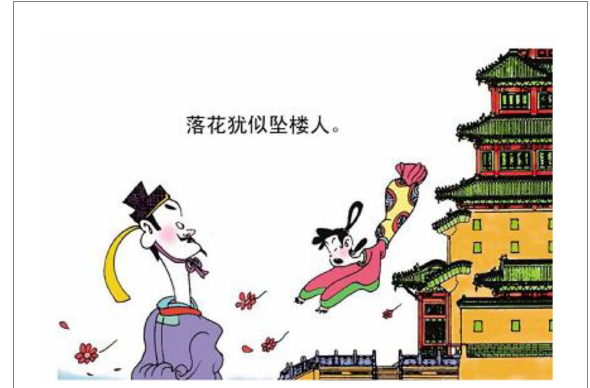
FIGURE 13 The fifth panel on Cai (2014, p. 136). Images reproduced with permission from Shang Dong People Press.